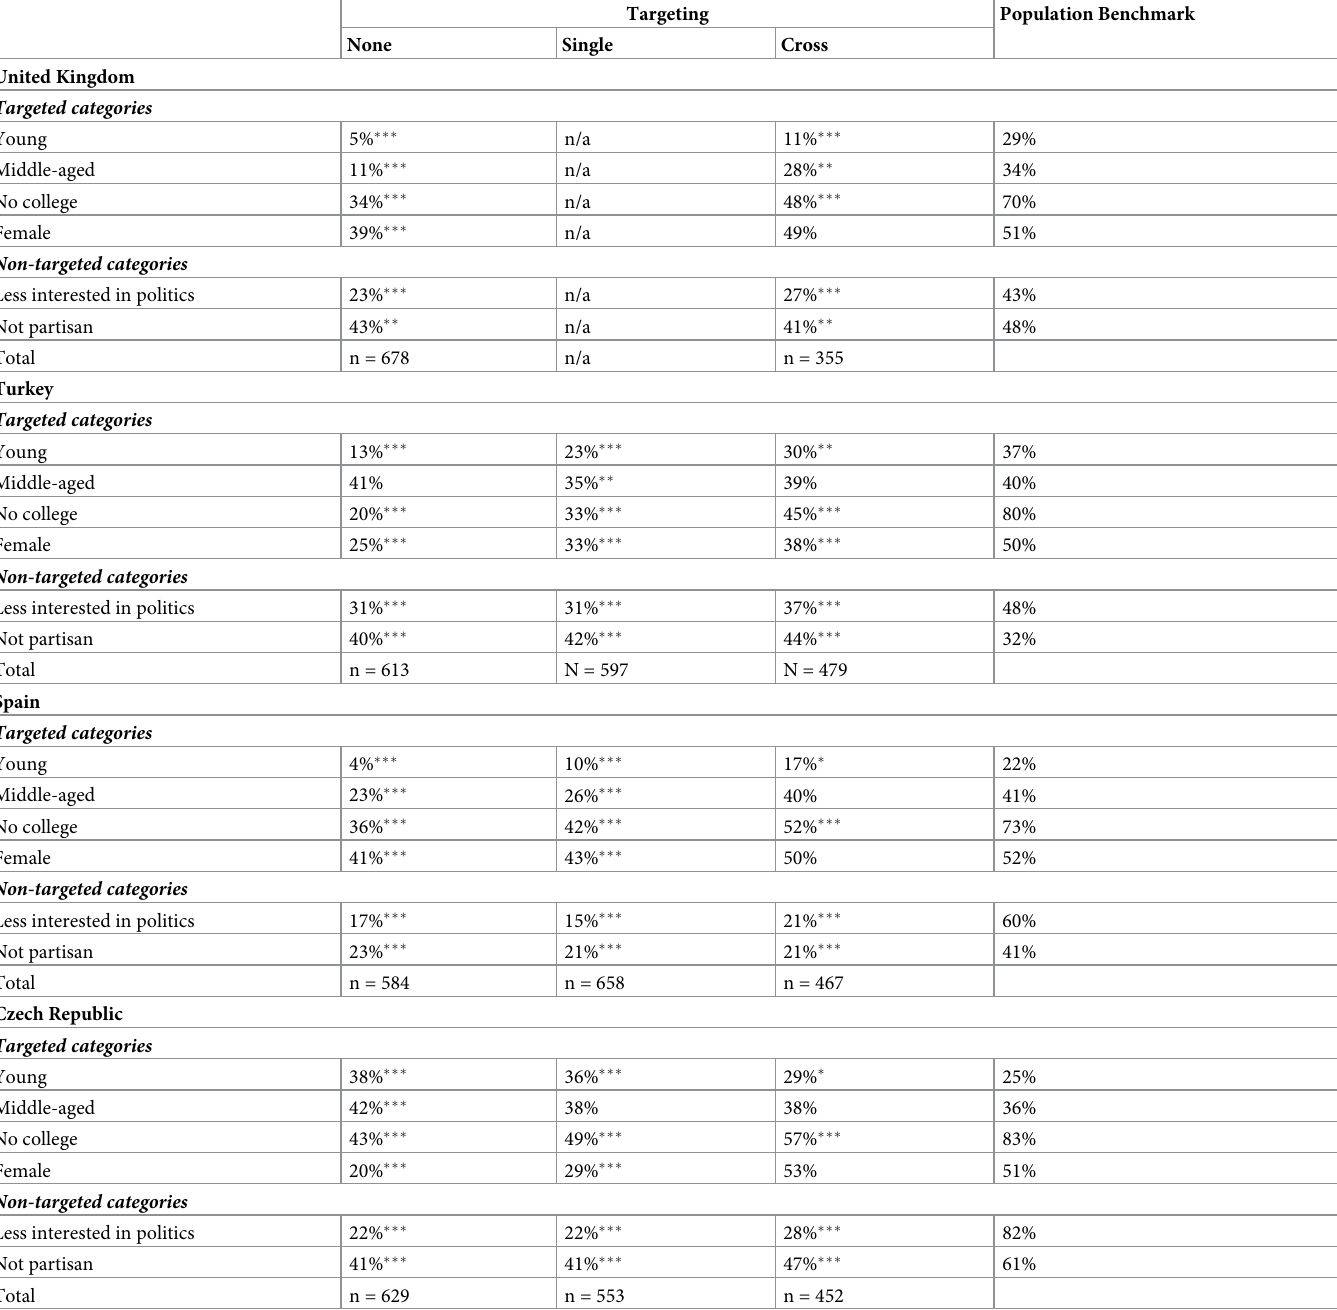
Table 6. Single group distributions of participants recruited through